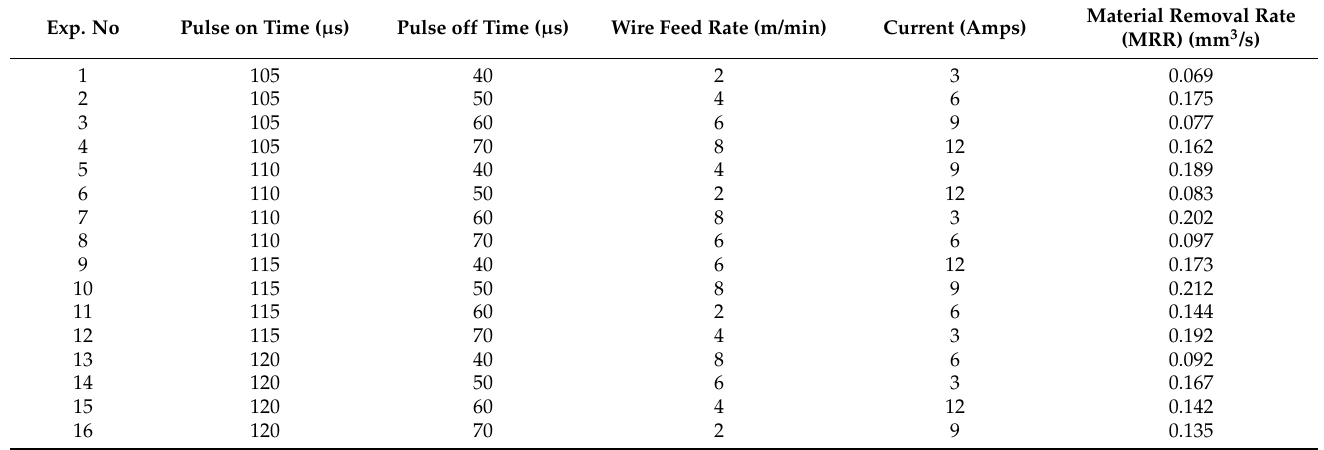
Table 5. Summary of WCEDM and material removal rate (MRR) results.